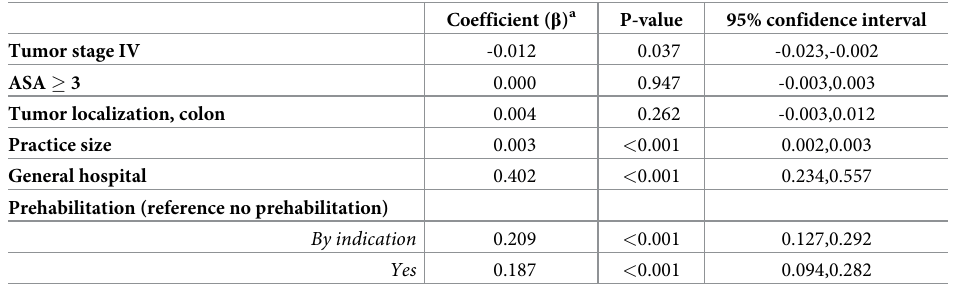
Table 3. Results of truncated regression